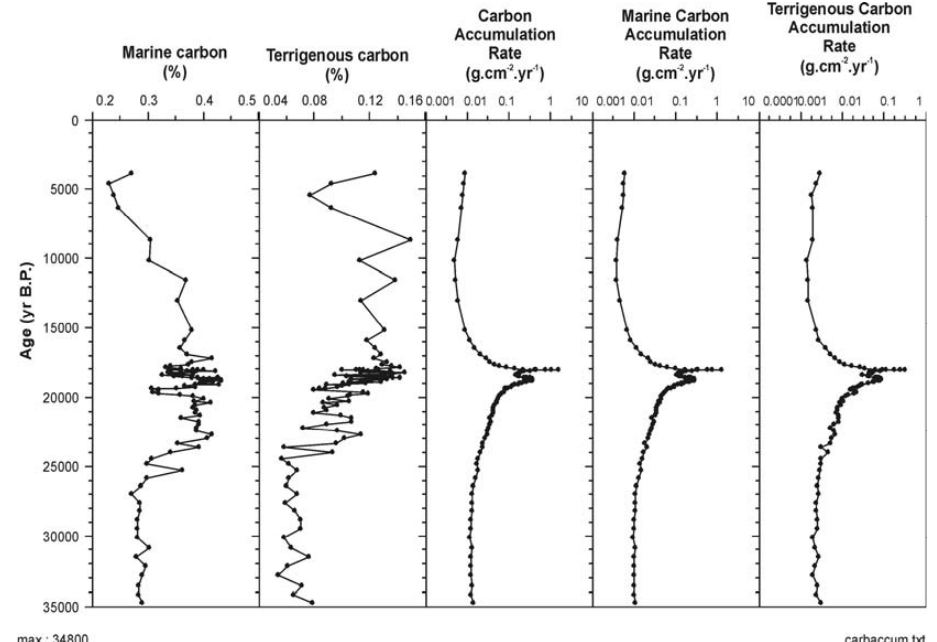
Fig. 6 – Variations in marine and terrestrial organic carbon content and accumulation rates in core 7485. Isotope stage limits based on Martinson et al.